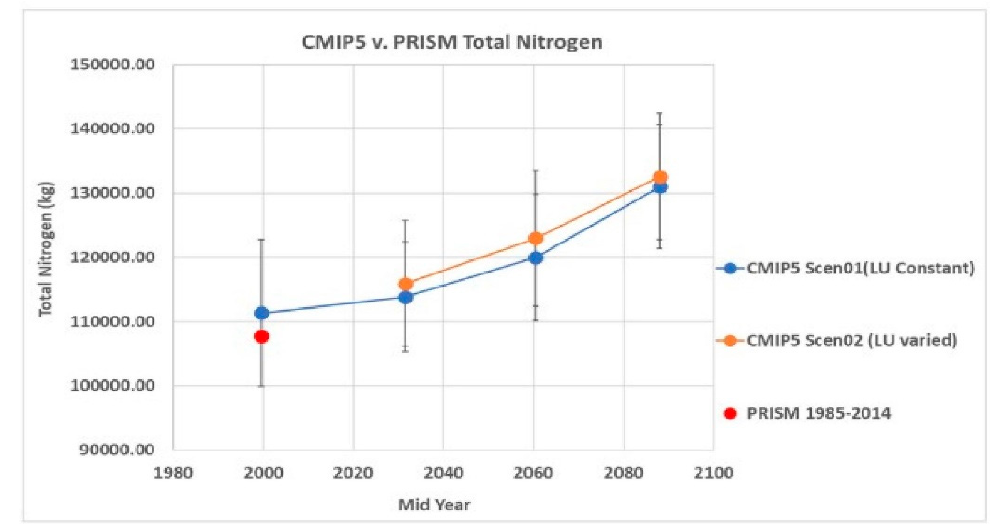
Figure 12. PRISM vs. average of 20 CMIP5 GCMs total nitrogen (2018–2100).